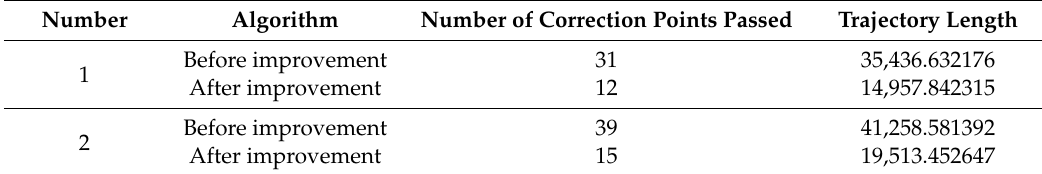
Table 5. Performance comparison of A* algorithm and the proposed improved sparse A*